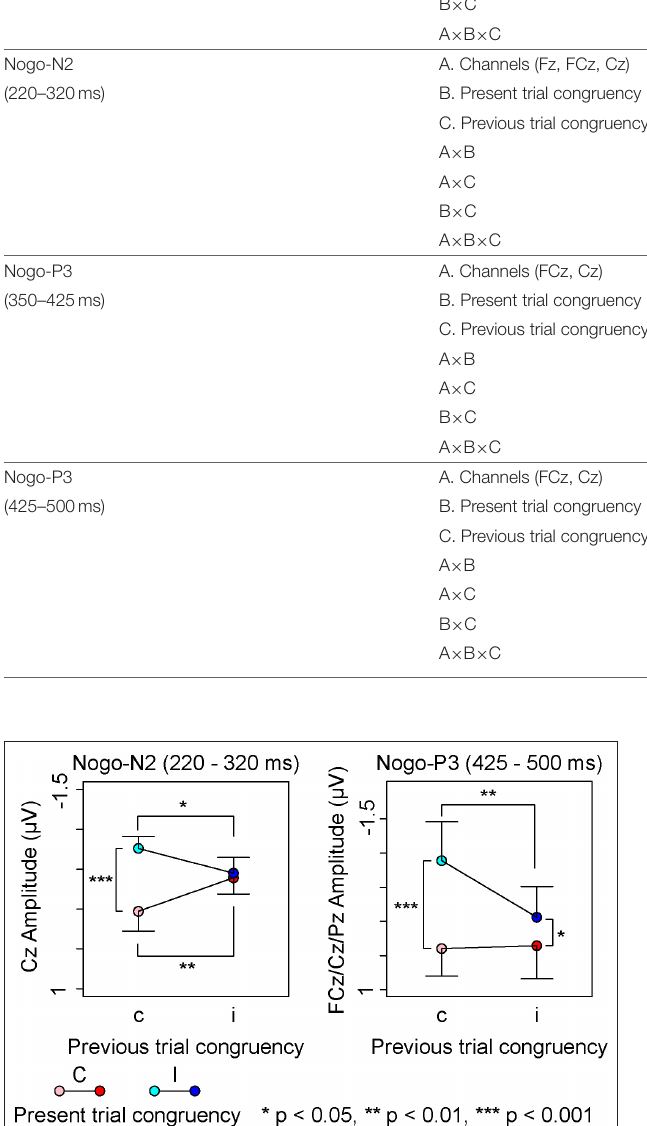
trials preceded by incongruent stimuli, which reduced efforts for cognitive control and response inhibition (Botvinick et al.,